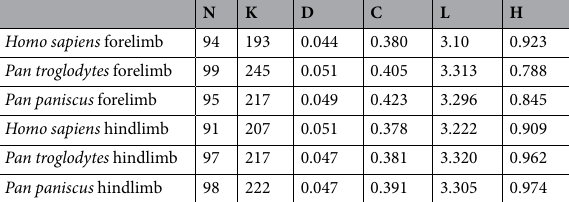
Table 1. Network parameters of musculoskeletal